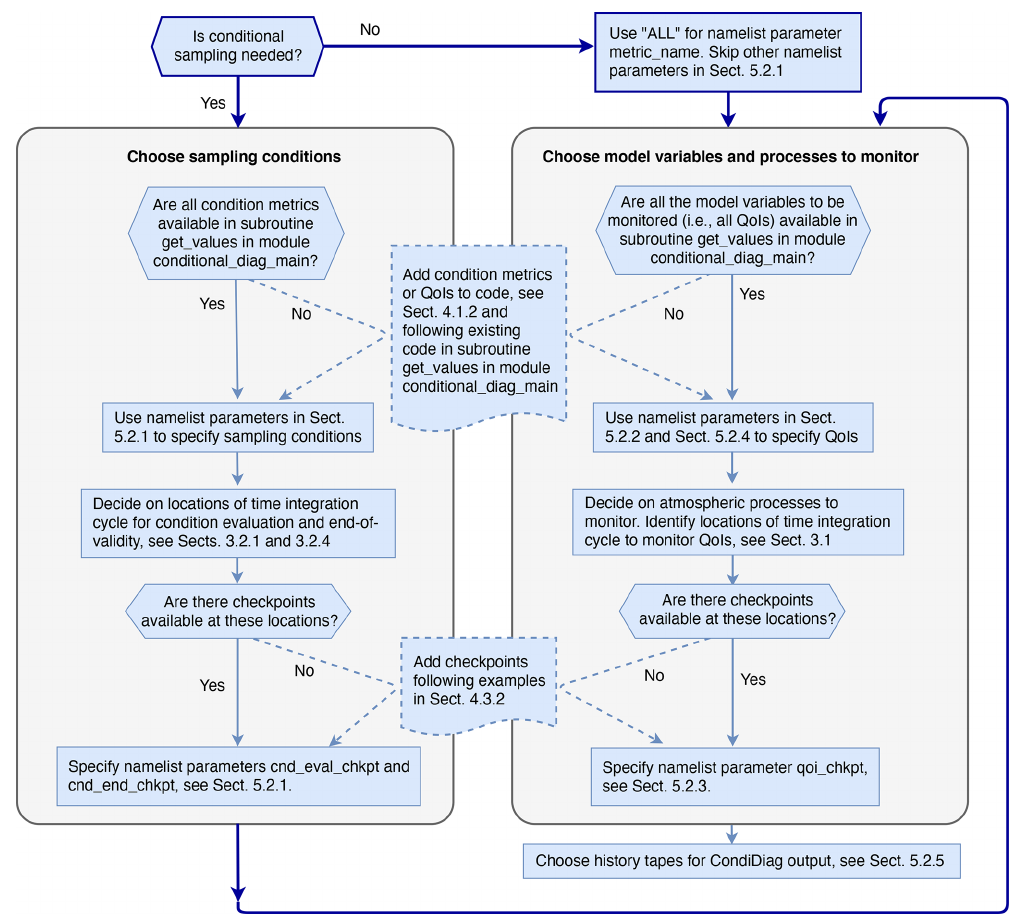
Figure 4. A schematic showing the typical steps a user needs to go through for setting up an EAM simulation with online conditional sampling or budget analysis enabled using our tool. Dashed lines indicate places where code changes or additions are needed from the